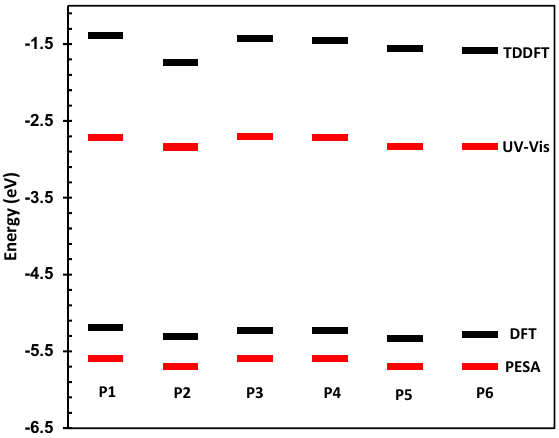
Figure 3. Predicted and measured HOMO and LUMO energy levels for P1 – P6 .